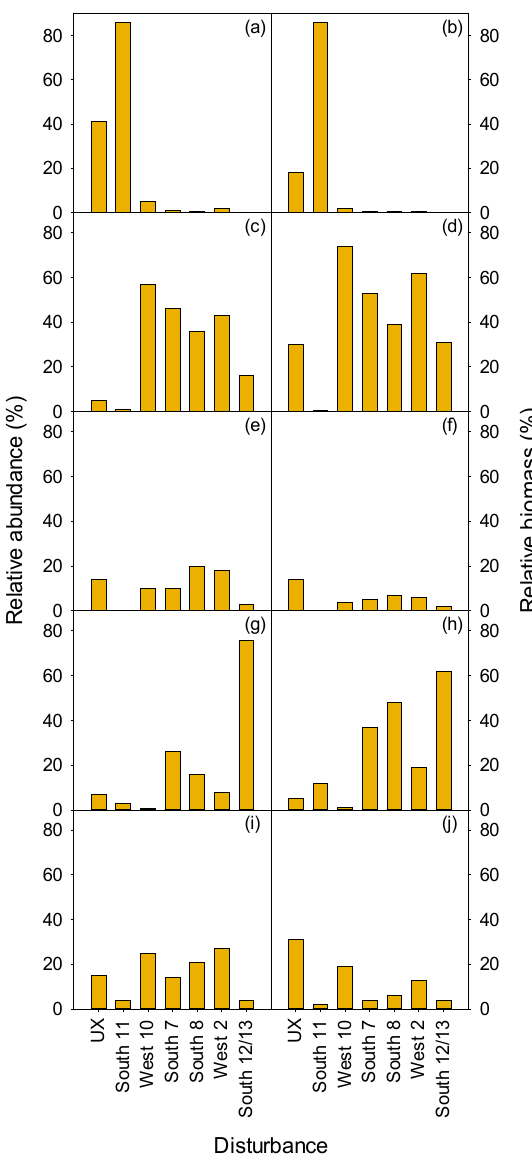
Figure 10. The Xerophyllum tenax (XETE) habitat type phase 30 years after disturbance and the relative abundance values (%) for trees of ( a ) Abies lasiocarpa , ( c ) Larix occidentalis , ( e ) Picea engelmannii , ( g ) Pinus contorta , and ( i ) Pseudotsuga menziesii var. glauca , long with their respective relative biomass values (%) ( b , d , f , h , j ). Note: x-axis values progress from undisturbed forest (left) to the highest severity disturbance (right); see Table 1 for disturbance category descriptions.